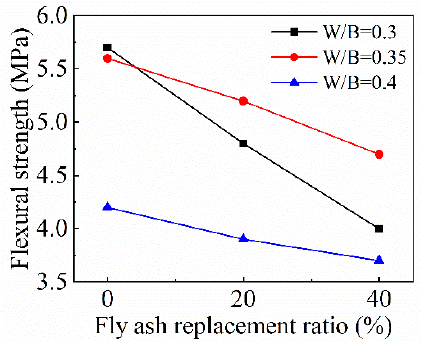
Figure 14. Variation of FRAC flexural strength with fly ash replacement ratio.